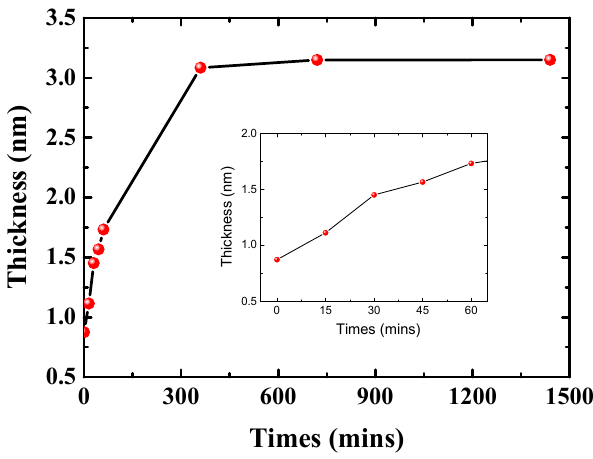
Figure 2. SiO x thickness for the Si substrates exposed in air for different times.